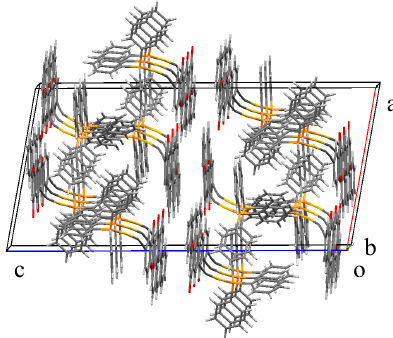
Figure 3. Crystal packing of 6 , showing the planar aromatic layers between the chromone units and the face-to-face arrangement of the triphenylphosphine gold units (o = origin; a, b, c = crystallographic axes).